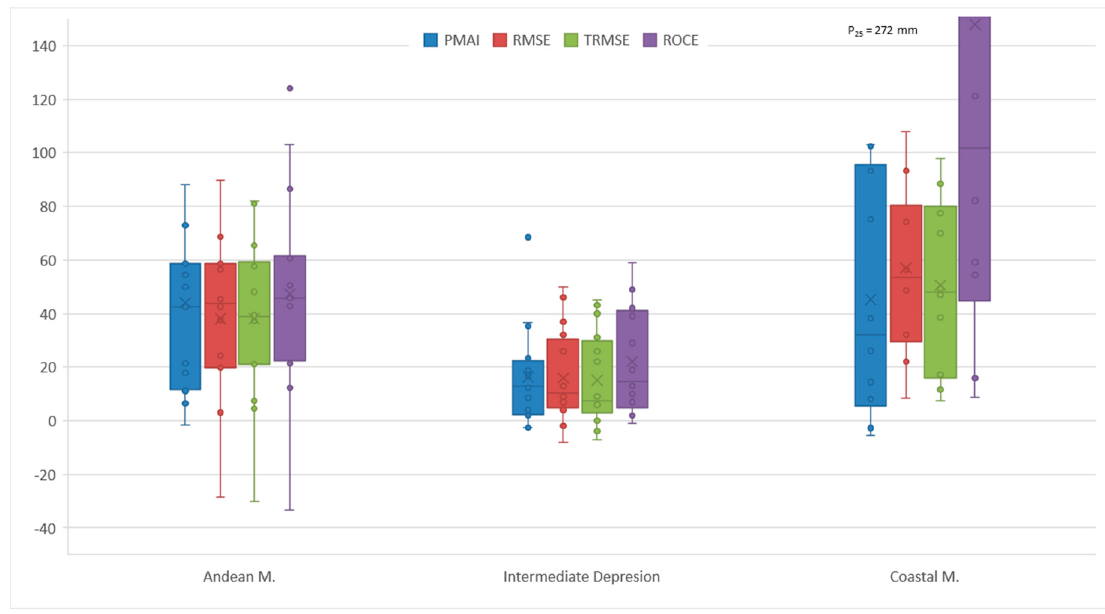
Figure 3. Percent difference in the AAP calculated by isohyets and inverse modeling for each watershed. Made by the authors.